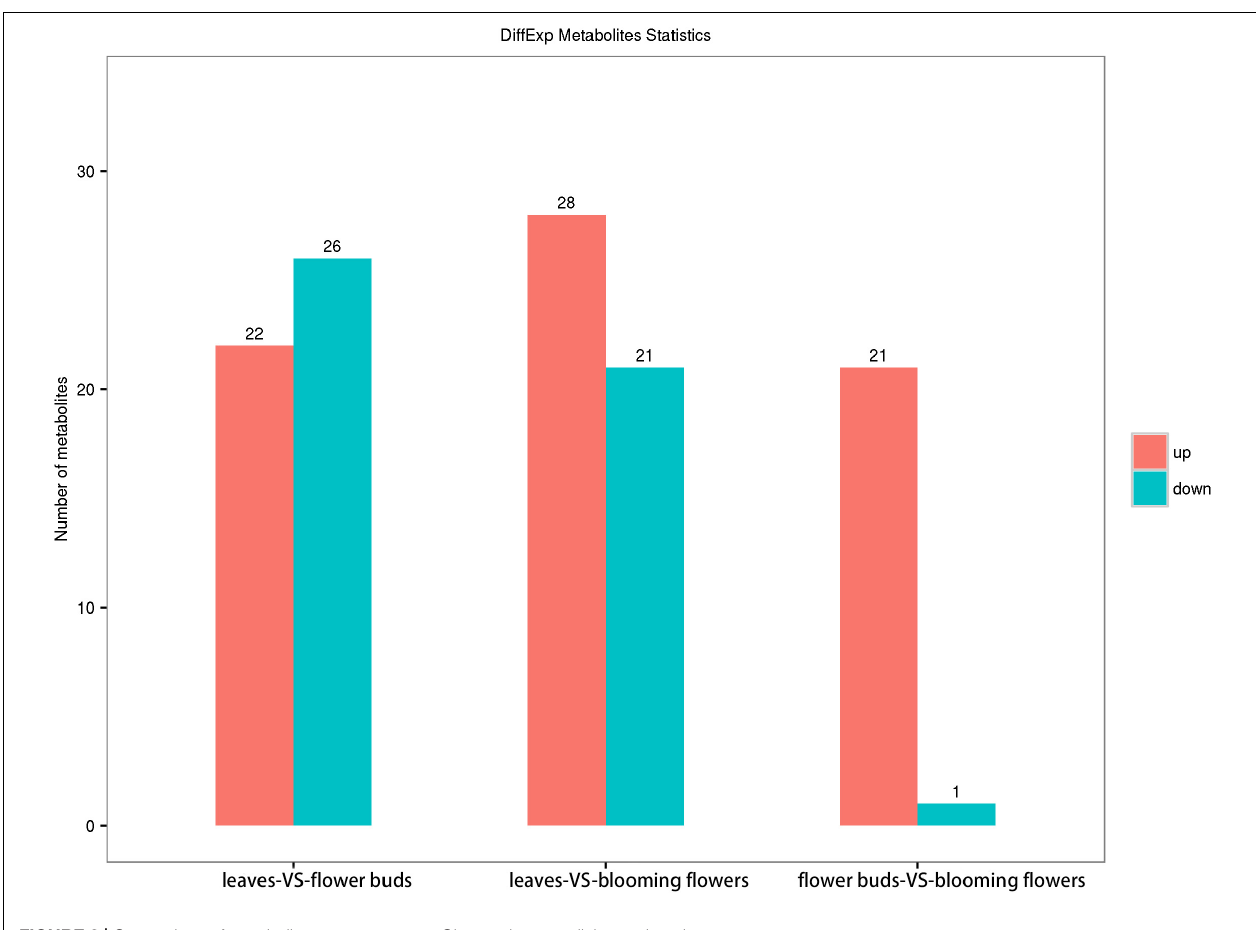
FIGURE 8 | Comparison of metabolite contents among Chrysanthemum dichrum plant tissues.